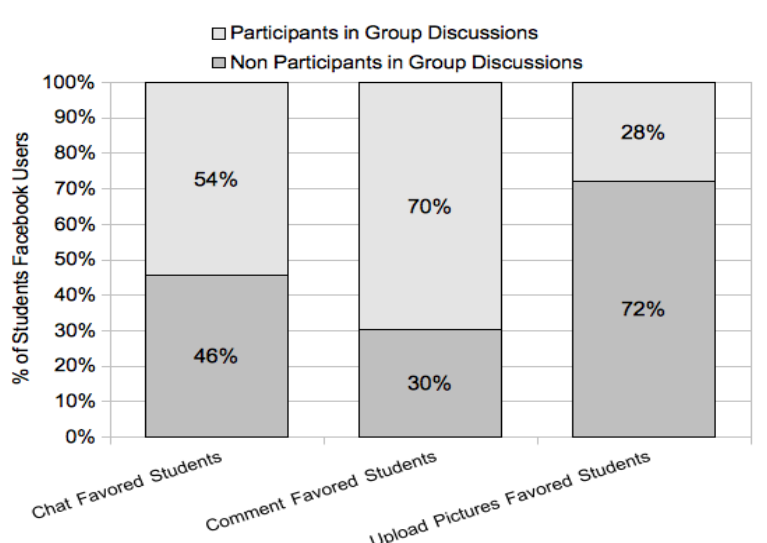
Figure 14. Participants in Facebook groups categorized by favorite Facebook features. The group of students who favored the comments feature had the highest number of participants in Facebook groups discussions (Figure 14), suggesting that their favor of the comment feature fits group discussions. Whereas, over 50% of students who favored the chat feature participate in Facebook group discussions. Also, around 30% of students who favored the upload picture feature participate in Facebook group discussions.